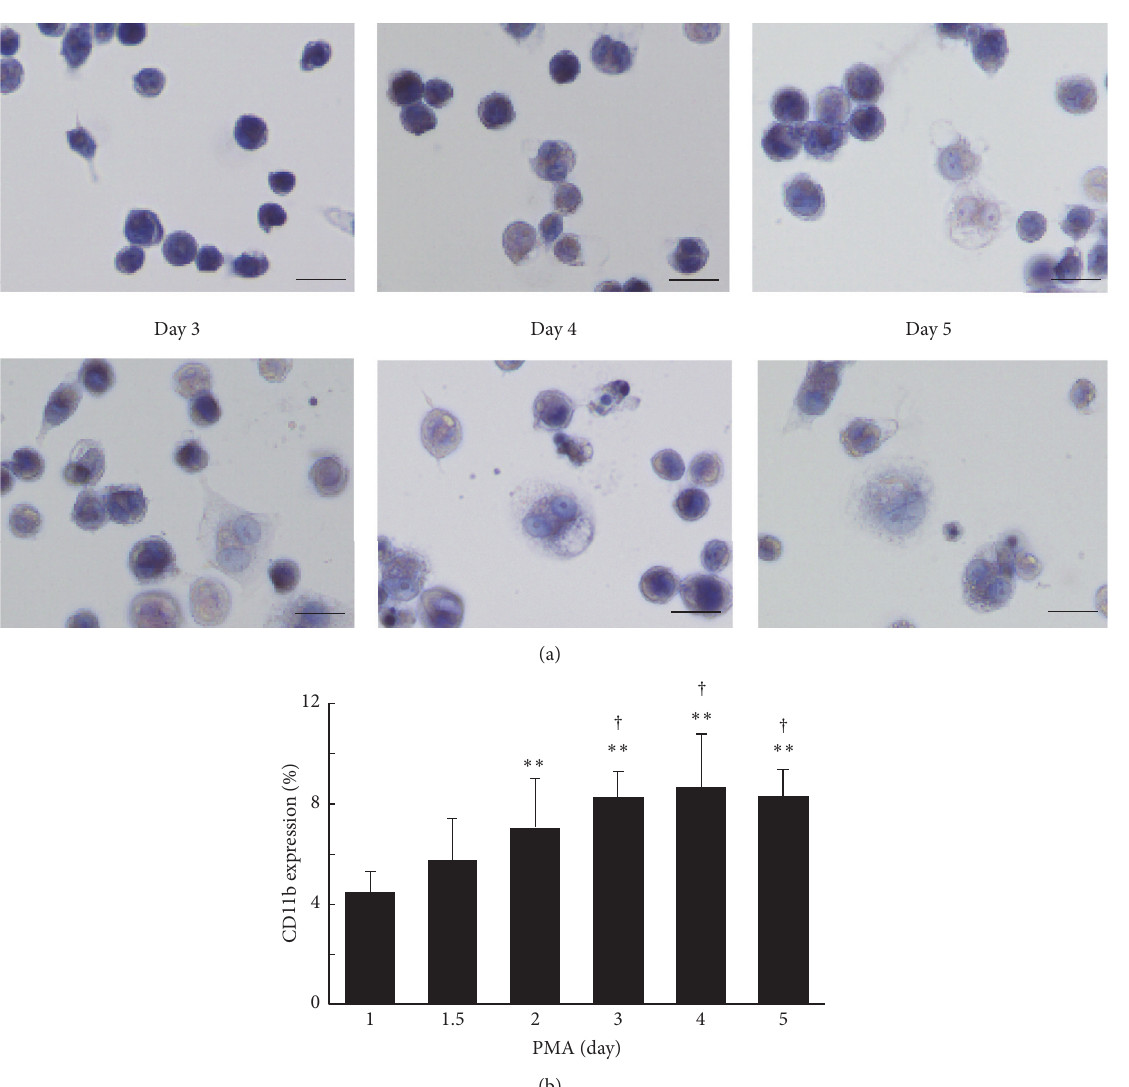
Figure 1: The morphological changes in THP-1 cells. THP-1 cells were treated with 100 ng/mL PMA for different duration (1 to 5 days). After treatment, (a) THP-1 cells were fixed with 3.7% formaldehyde and stained with hematoxylin (scale bars, 20 𝜇 m). (b) THP-1 cells were incubated with FITC-conjugated anti-CD11b antibody, and CD11b expression was analyzed using flow cytometry. The percentage of CD11b positive cells which exceeded the maximum fluorescent intensity of the isotype control in each day was indicated. The value at day 1 was defined as 1. The values were indicated by mean + SD ( 𝑛 = 5, ∗∗ 𝑃 < 0.01 versus day 1, † 𝑃 < 0.05 versus day